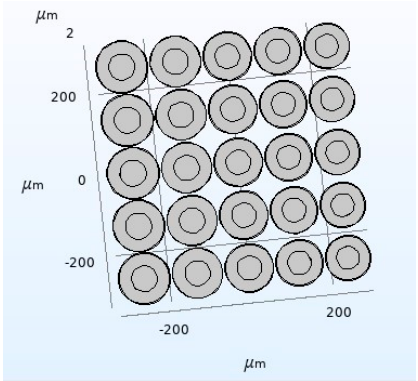
Figure 11. A CMUT model of five cell sizes.